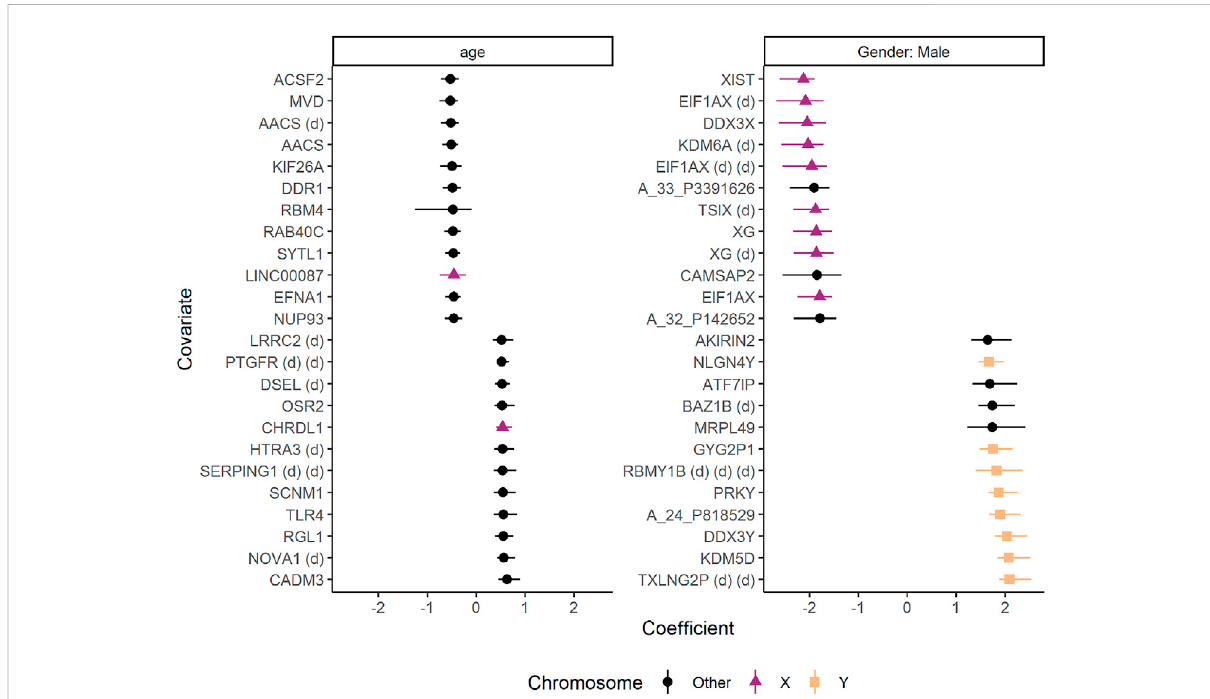
FIGURE 11 The effects of age and gender on gene expression in skin biopsies from healthy controls and patients with systemic sclerosis. The coef fi cients areregressioncoef fi cients fromlinear regression models, colored bychromosome location. Somegenes wereassociatedwith mulitpleprobes,and are marked with “ (d) ” to avoid duplicated names. The error bars re fl ect 95% con fi dence intervals from bootstrapping. Only the 12 genes with highest and lowest coef fi cients are shown. The fi gure was made with the plot( ... , type = “ covars ” )